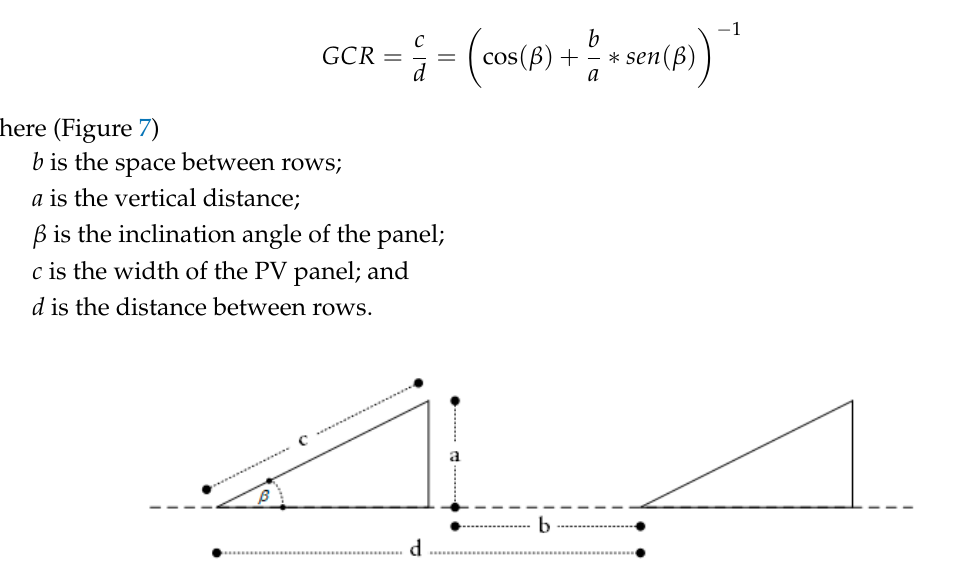
Figure 7. The ground coverage coefficient.